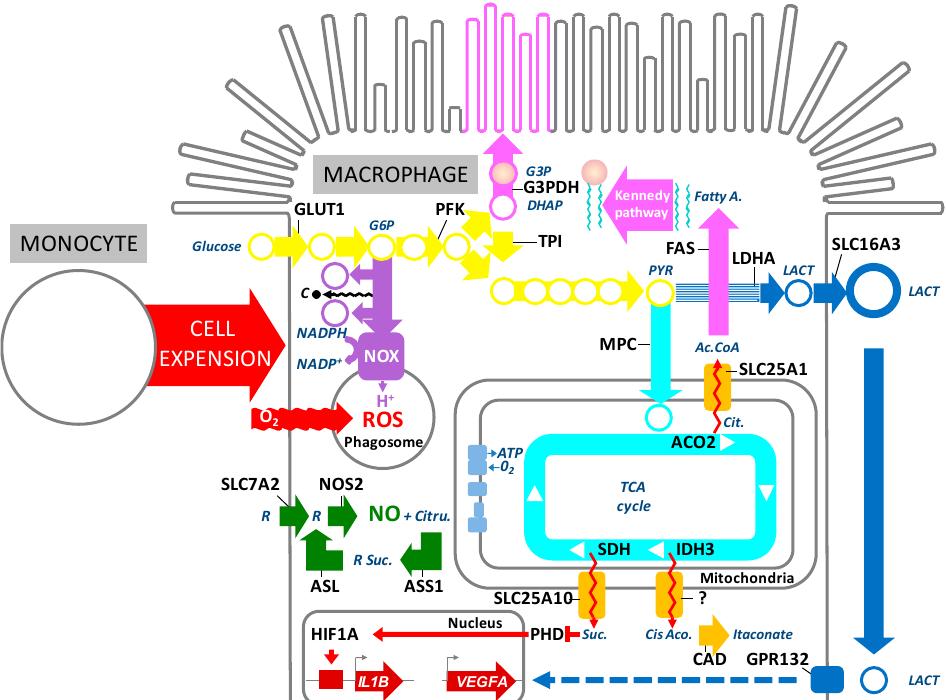
Figure 2. Metabolic reprogramming of inflammatory macrophages. Ac.CoA: